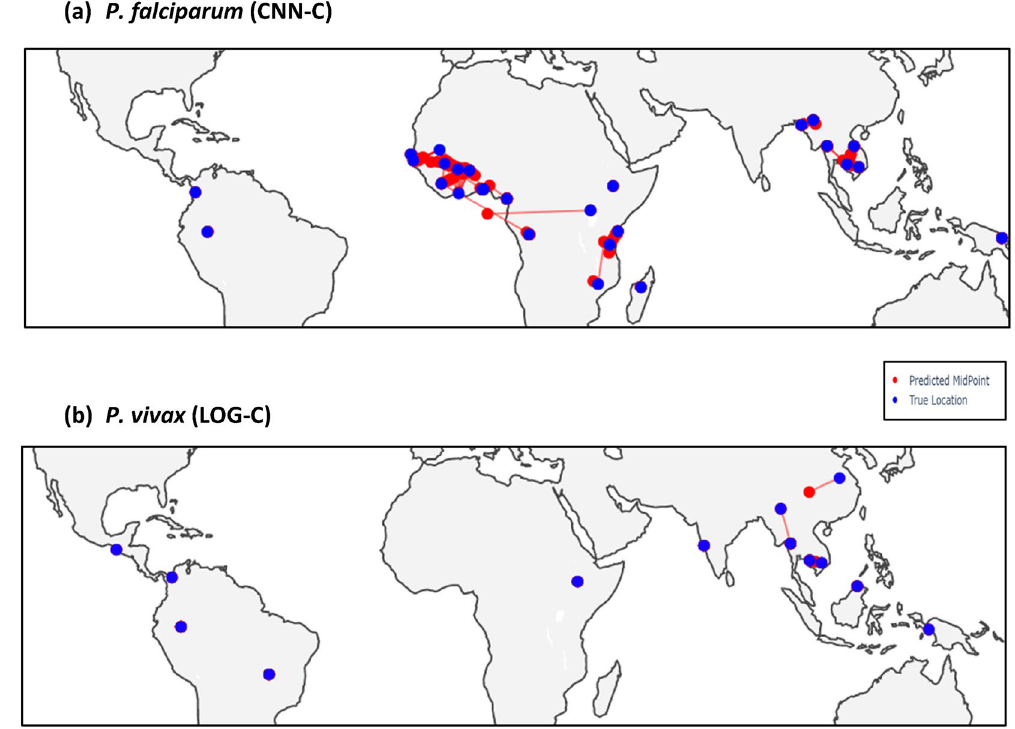
Figure 3. Maps with predicted vs. actual locations for the best predictive models. Blue points are the actual locations in the dataset, red points are the predicted locations (where different to actual), with red lines link the actual and the predicted locations. CNN-C deep learning Convolutional Neural Network classifier. LOG-C penalised multinomial logistic regression